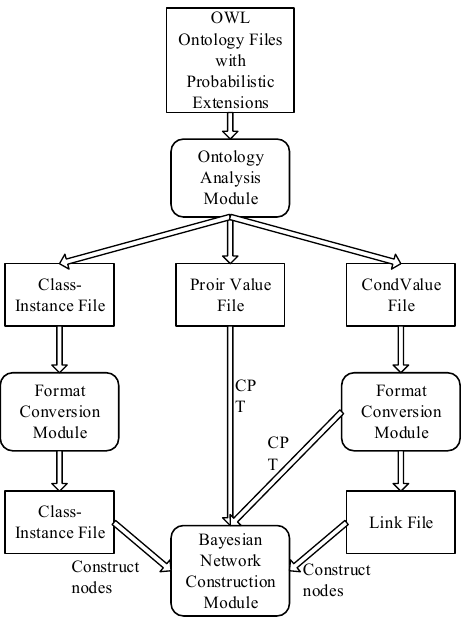
Figure 8. Overall framework of OntoBayes